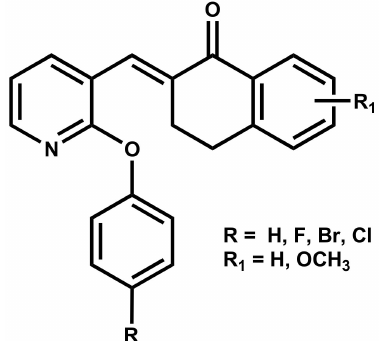
Figure 1. Structures of chalcone derivatives 8 – 23